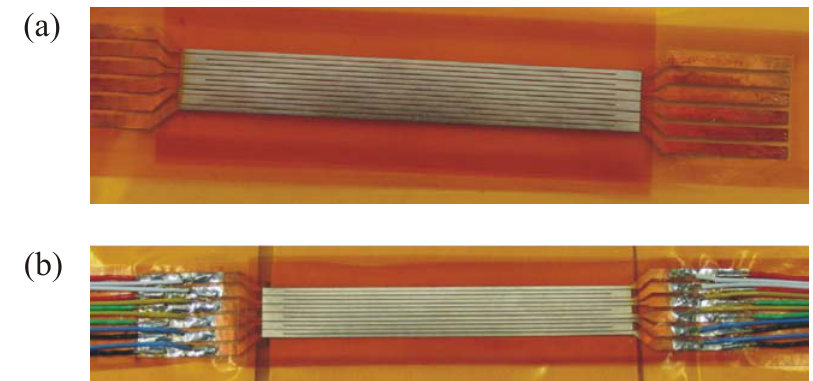
Figure 6. Complete laminated sensor. (a) sensor without electrical connections. (b) sensor with electrical connections.